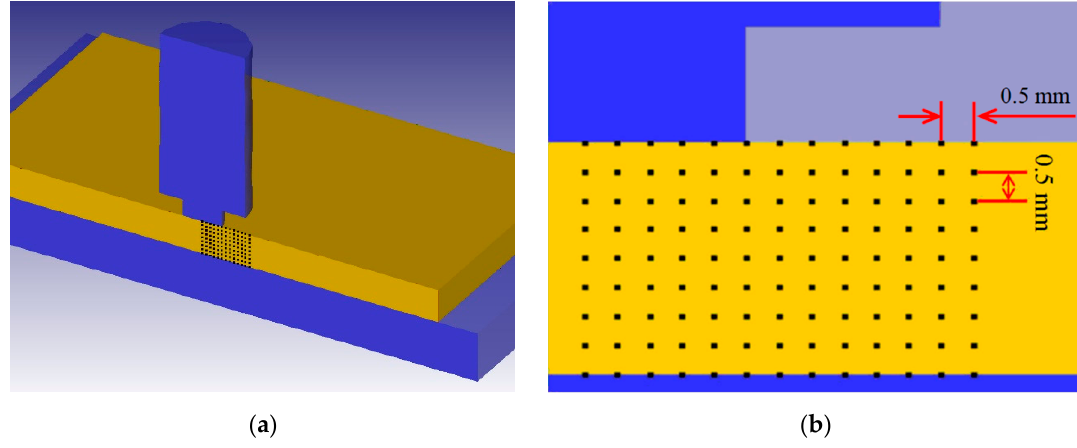
Figure 15. Schematic of point tracking: ( a ) initial location of tracking points; ( b ) distribution of the point.